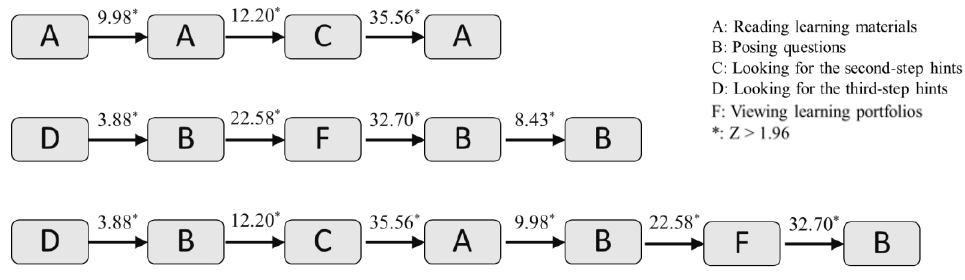
Figure 8. The complex behavioral transitional patterns.